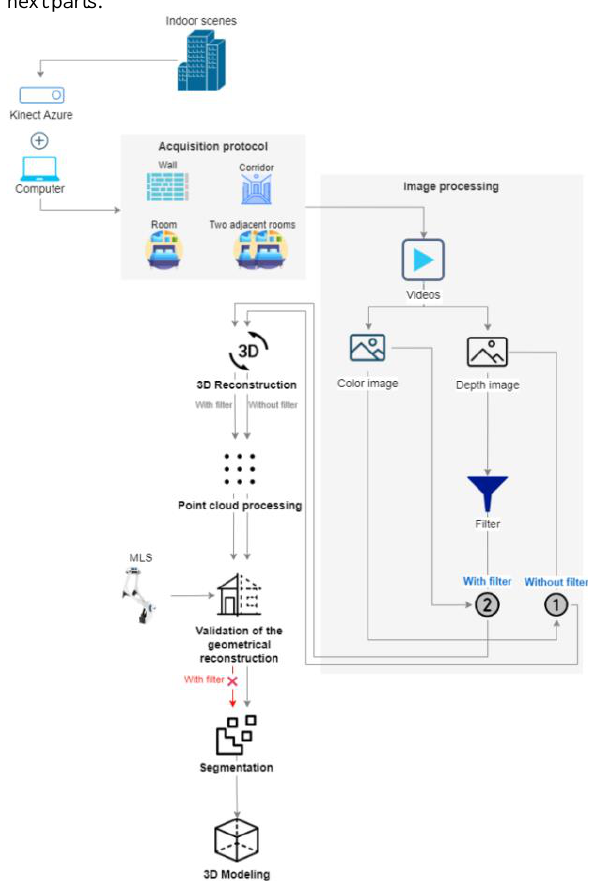
Figure 1. Flow chart of the process developed in this